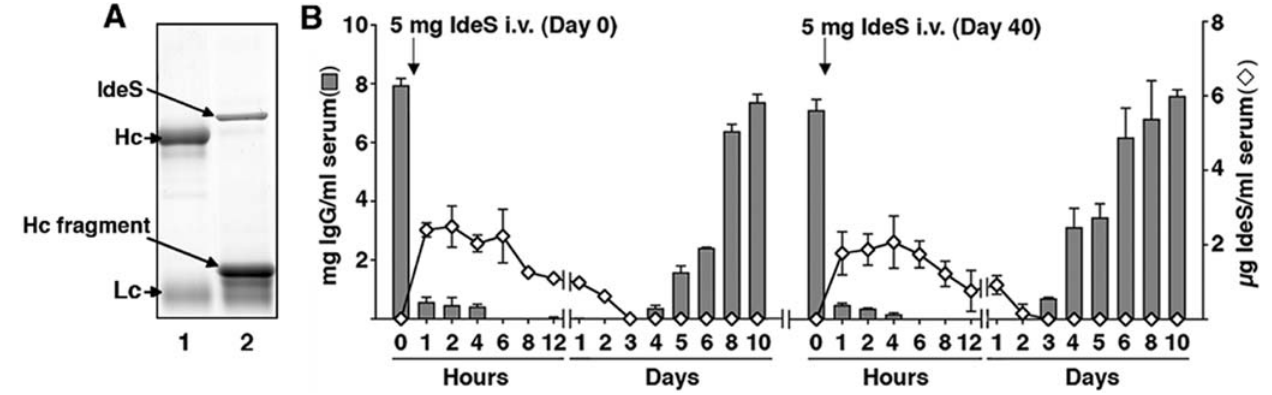
Figure 3. Invivo cleavage and removal of IgG from the blood circulation of rabbits injected with IdeS. (A) SDS-PAGE of rabbit polyclonal IgG (5 m g in 10 m l PBS) alone (lane 1), or preincubated with IdeS (5 m g IgG and 1 m g IdeS in 10 m l PBS) for three hours at 37 u C (lane 2). Bands corresponding to IdeS (61 kDa), IgG heavy chains (Hc, 56 kDa), IdeS-generated Hc fragments (31 kDa) and IgG light chains ( Lc, 25 kDa), are indicated. ( B) Levels of IgG (grey bars) and IdeS ( e ) in serum samples from a rabbit injected i.v. with IdeS (5 mg diluted in 2.5 ml PBS). IgG was determined by ELISA and IdeS by Western blotting and chemoluminescence in a Chemidoc XRS Imaging system. Samples were analyzed three times and mean values 6 SD are